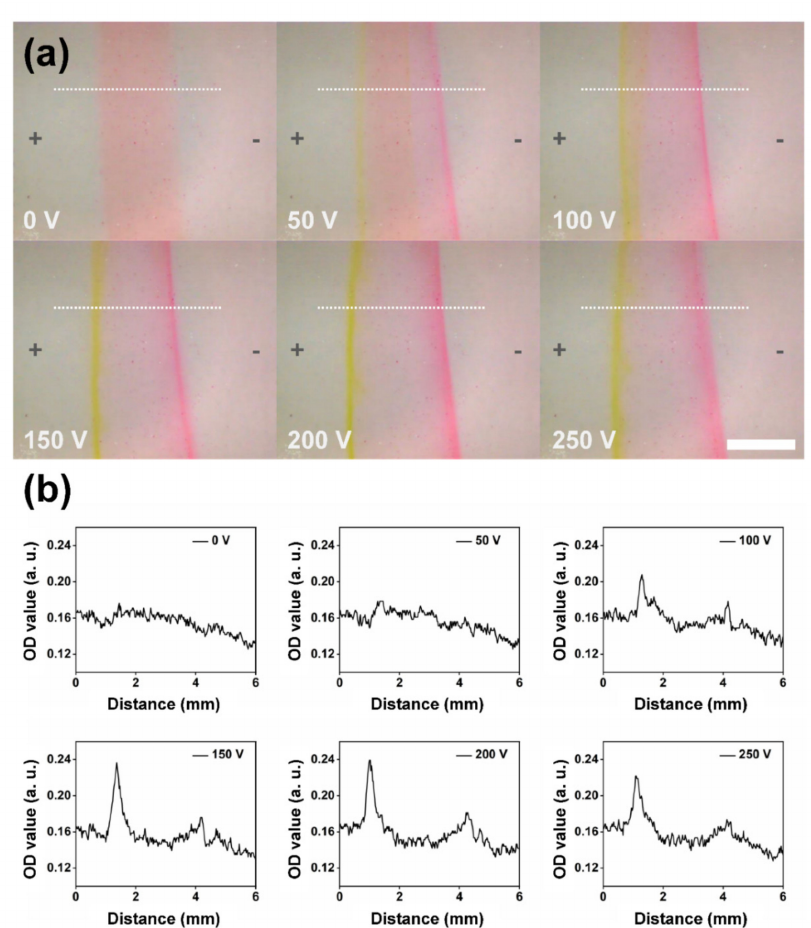
Figure 3. ( a ) Optical micrographs of the sample solution (the mixture solution of Rh6G and NaFL) in the separation chamber under different applied voltages ranging from 0 V to 250 V. The direction of the electric field was from left (+) to right ( − ). The flow rates of sample solution and buffer solutions were set at 200 µ L/min and 3 mL/min, respectively. Scale bar: 2.5 mm. ( b ) Optical density (OD) value versus the horizontal distance along the separation chamber estimated from the dashed line in ( a ) with different applied